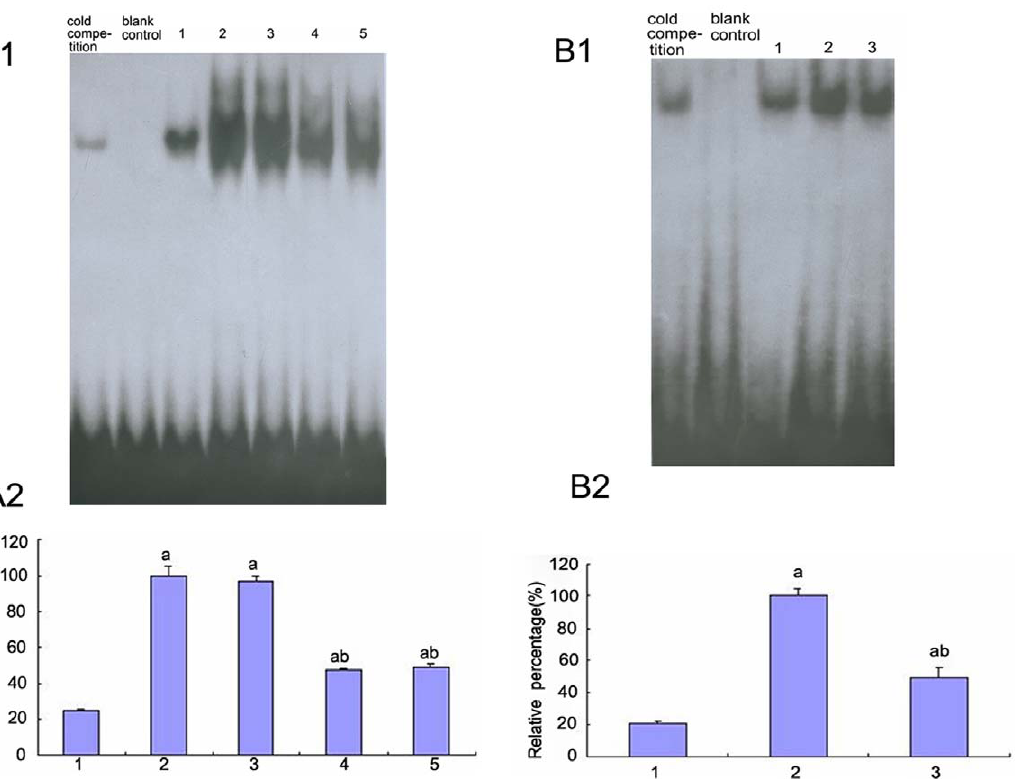
Figure 10. Activity of AP-1 in HK-2 cells by EMSA. (A)AP-1 activity was analyzed by EMSA of the HK-2 cells cultured in 5.5 mM glucose (lane 1), 30 mM glucose(lane 2), 30 mM glucose + Cont siRNA(lane 3), 30 mM glucose + p38 siRNA for 24 h (lane 4), 30 mM glucose + p38 siRNA for 48 h(lane 5).(B) AP-1 activity was analyzed by EMSA of the HK-2 cells cultured in 5.5 mM glucose(lane 1), 30 mM glucose (lane 2) and 30 mM glucose + AP-1 inhibitor(lane 3). Values represent the mean 6 SD, a P , 0.05 vs. 5.5 mM glucose, b P , 0.05 vs. 30 mM glucose.